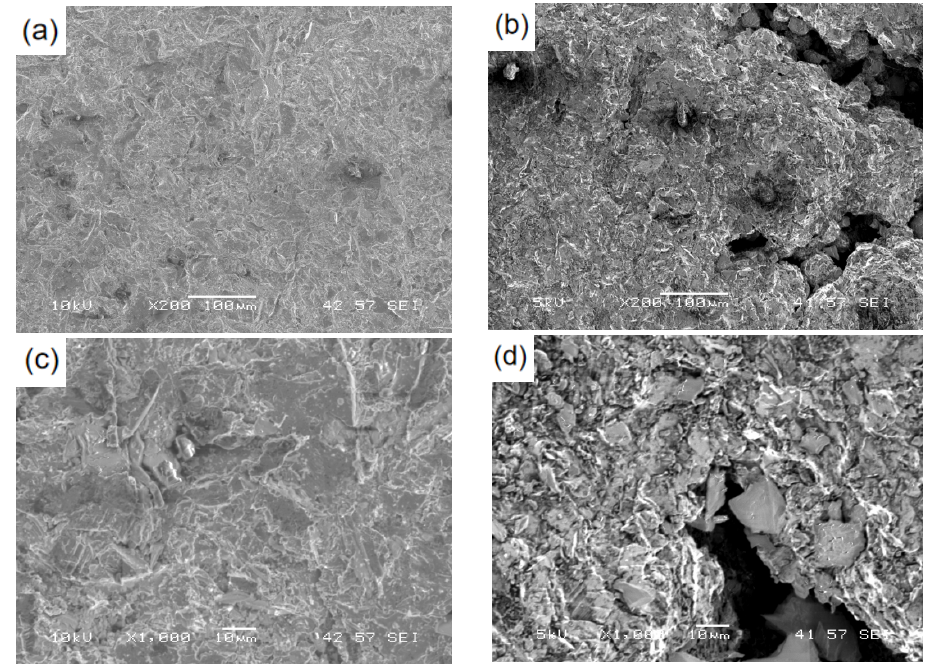
Figure 11. Surface topography before stretching: ( a ) flat-printed sample 200×; ( b ) vertical-printed sample 200×; ( c ) flat-printed sample 1000×; ( d ) vertical-printed sample 1000×.